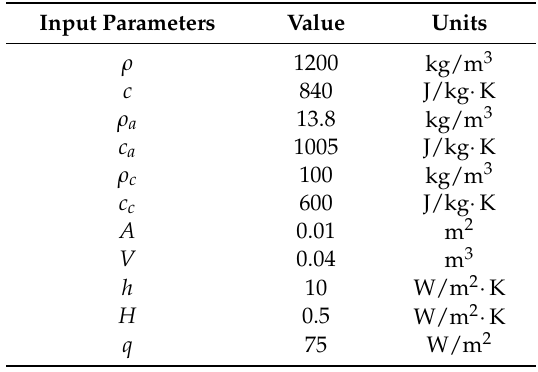
Table 1. Model input